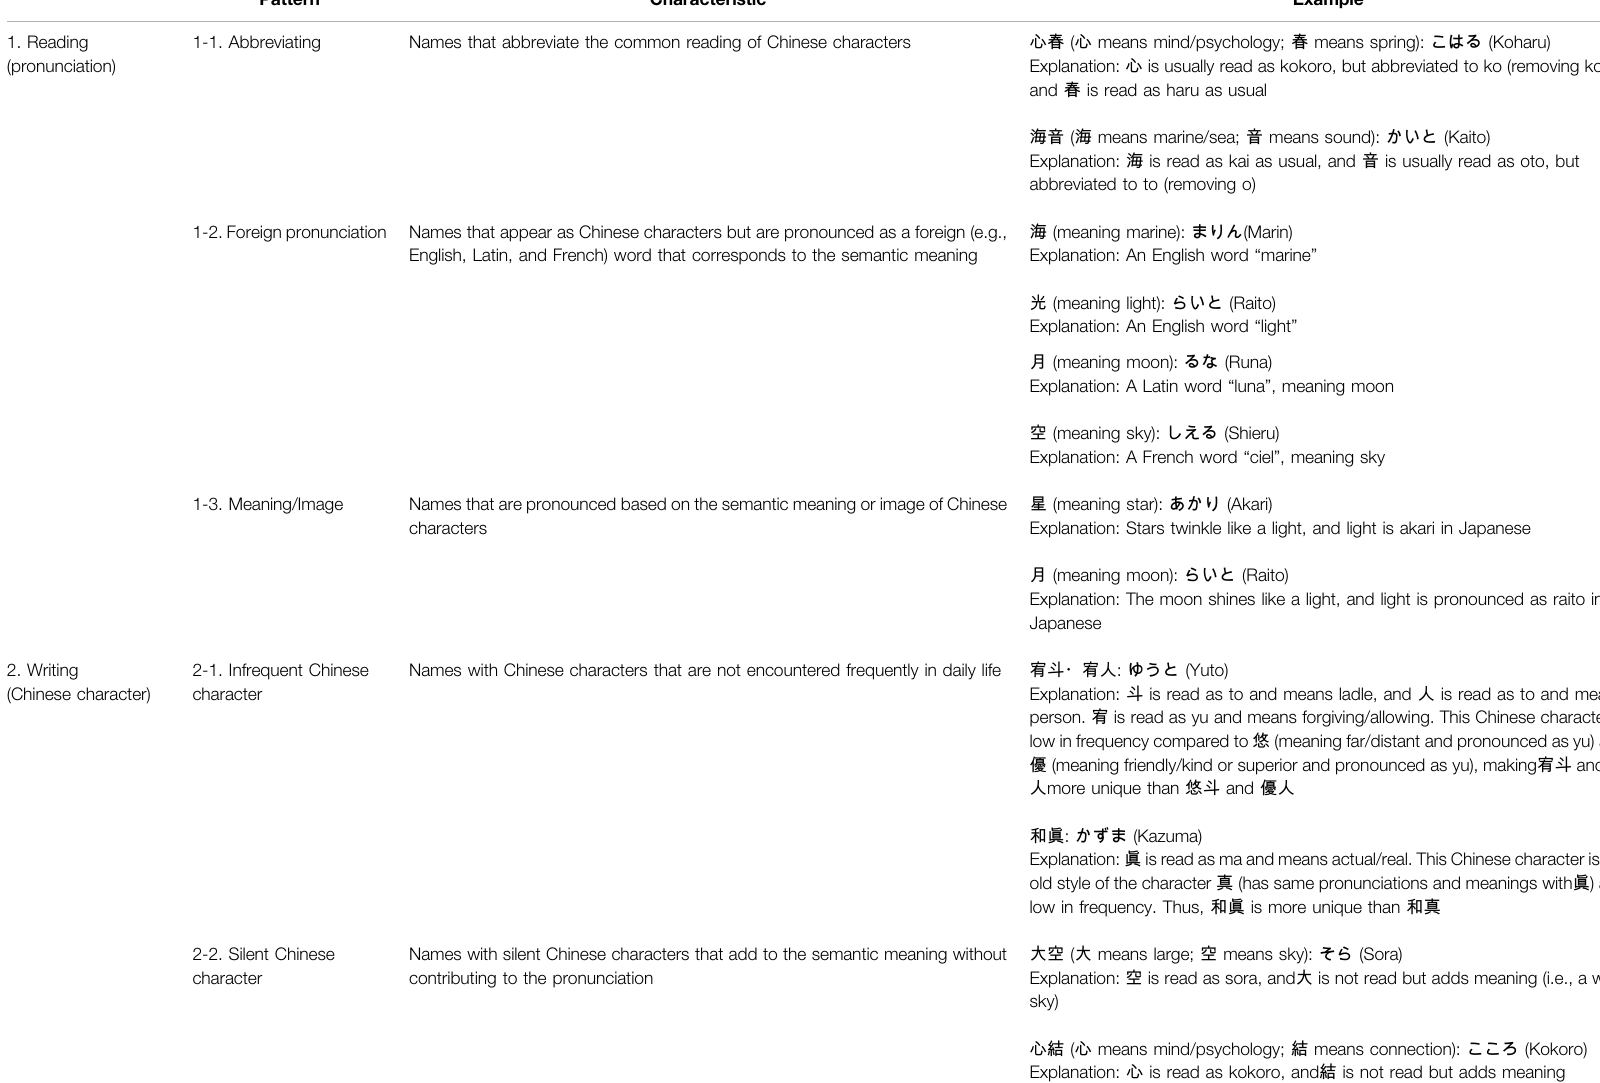
TABLE 1 | Patterns and characteristics of uncommon names in present-day